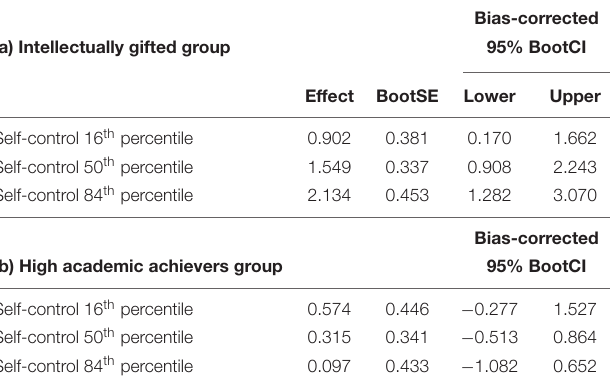
TABLE 5 | Conditional indirect effects of meaningfulness (M) on subjective well-being (Y) at various levels of self-control (M) among (a) intellectually gifted and (b) high academic